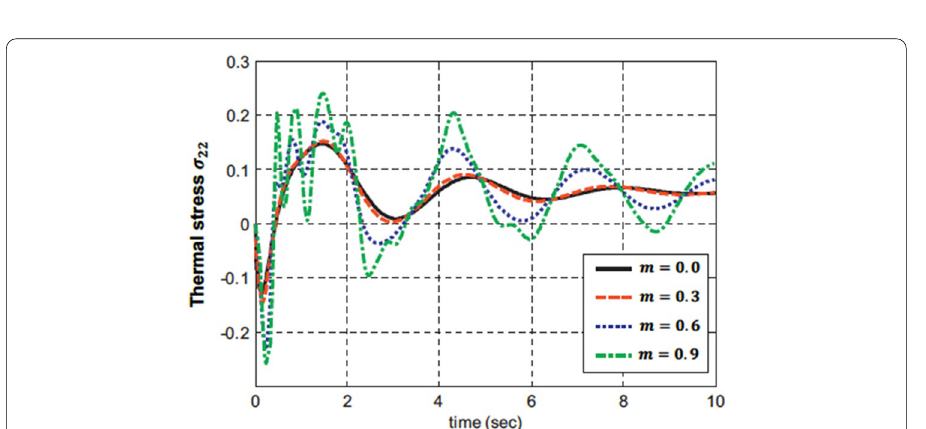
Fig. 8 Variation of the nonlinear thermal stress σ 22 with time τ for different values of functionally graded parameter